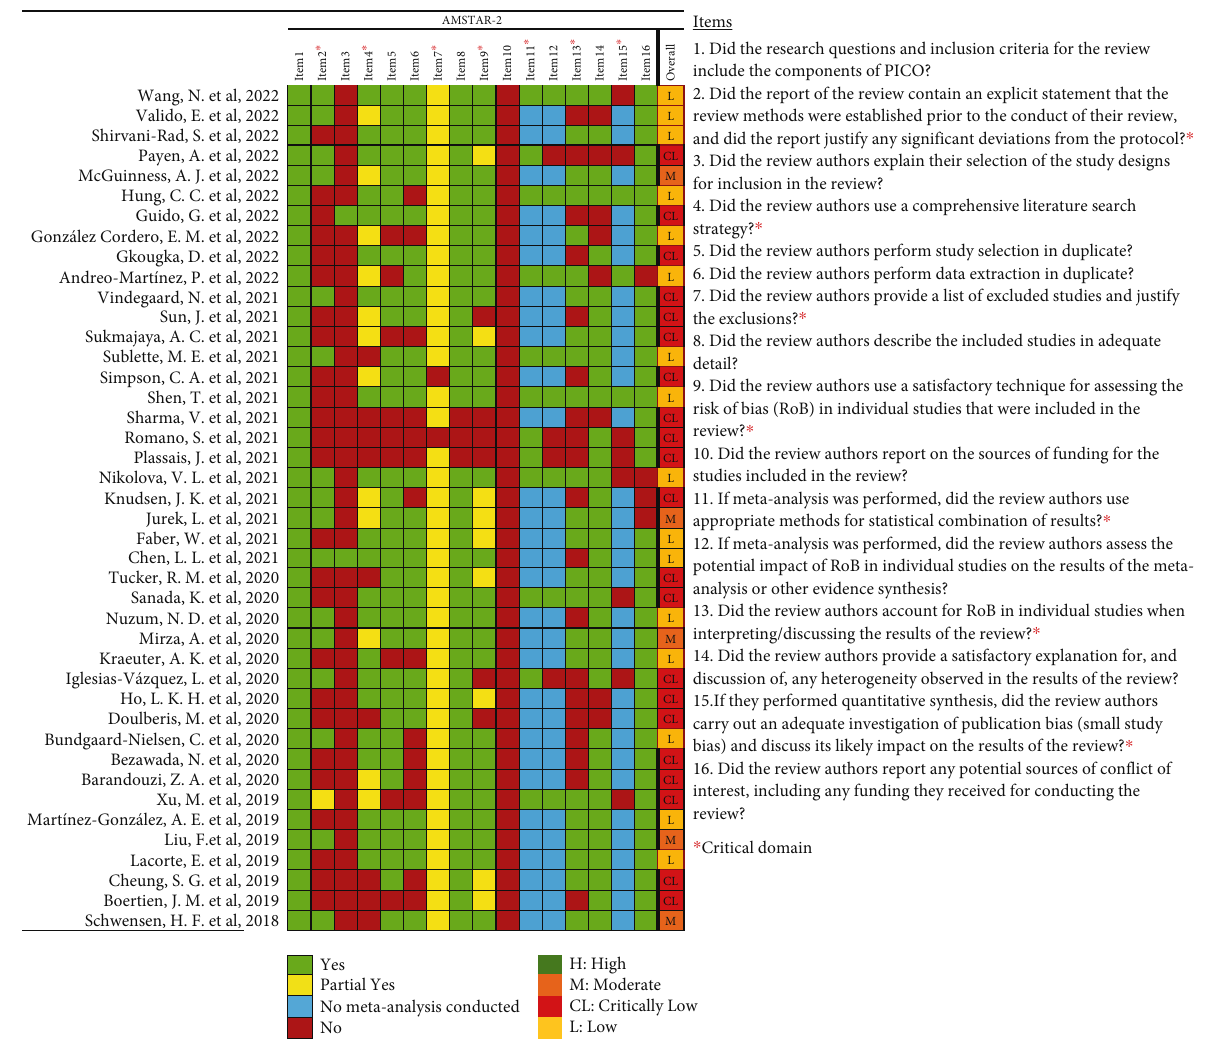
Figure 2: Methodological quality of the included